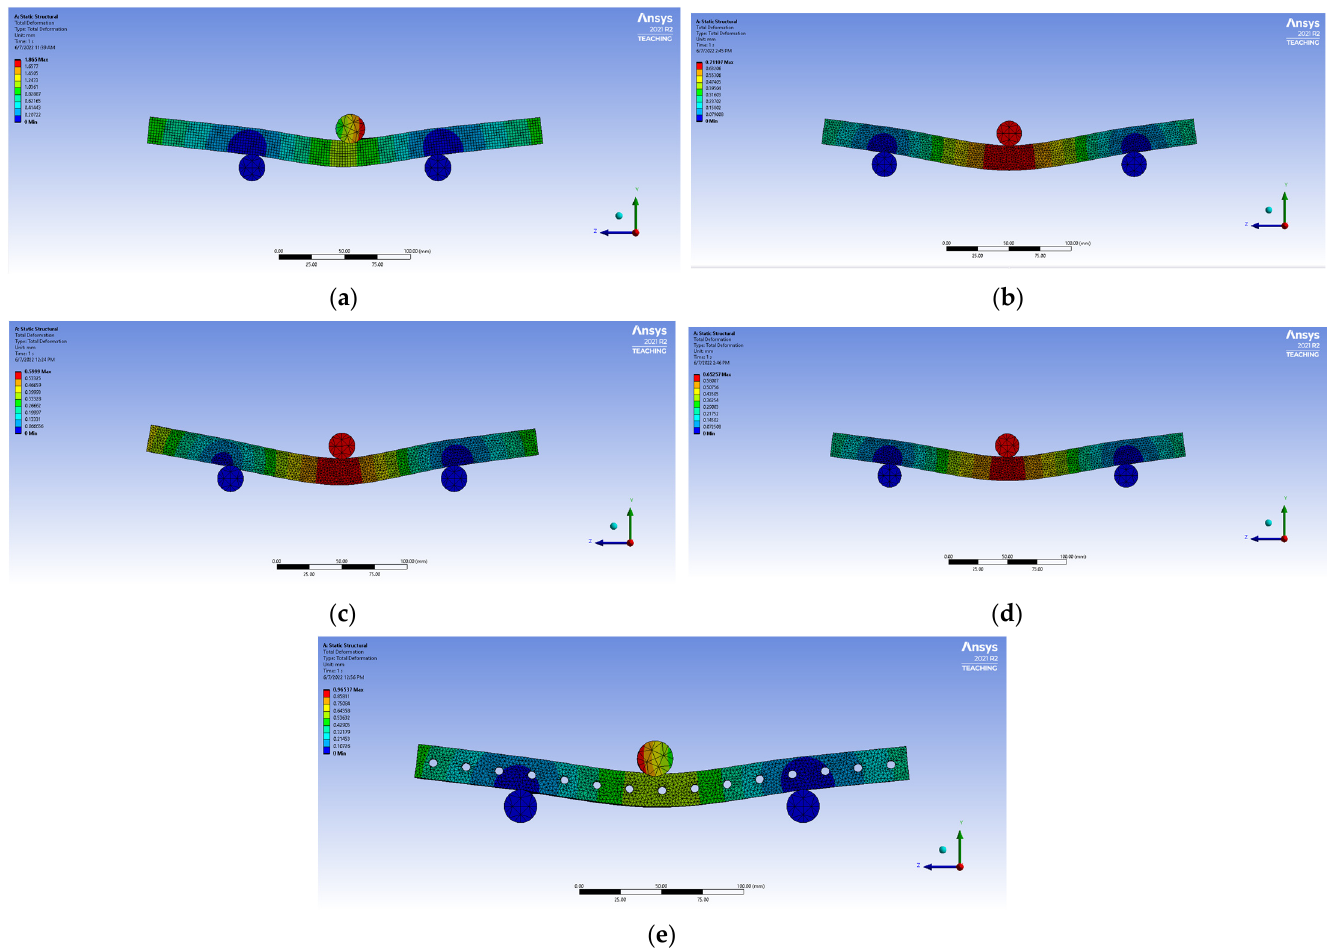
Figure 5. Sample outputs of numerical flexural performance at maximum deflection ( a ) plain AHT ( b ) AHT with circular hole ( c ) AHT with square hole ( d ) AHT with multiple circular holes and ( e ) AHT with perforations. Table 5. Crack dimensions of flexural failed